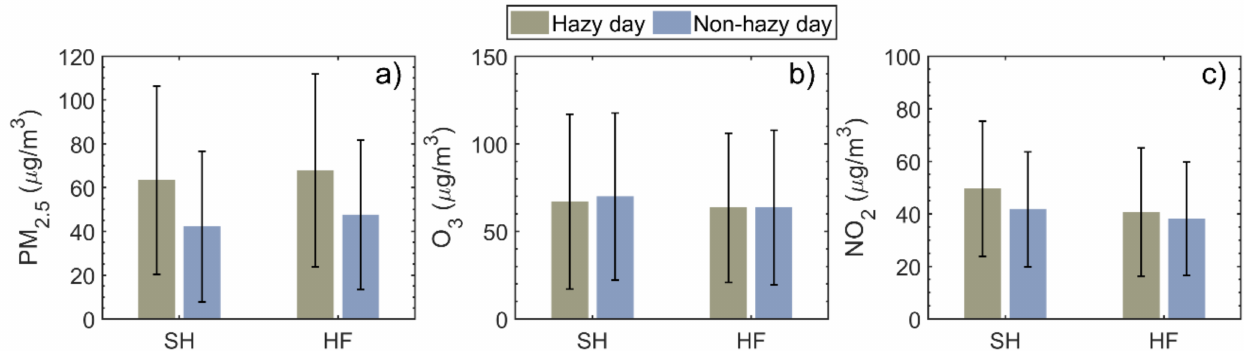
Figure 7. Daily mean concentrations of ( a ) PM 2.5 , ( b ) O 3 , and ( c ) NO 2 on hazy days (grey bars) and non-hazy days (blue bars) in Shanghai (SH) and Hefei (HF). Error bars denote the standard